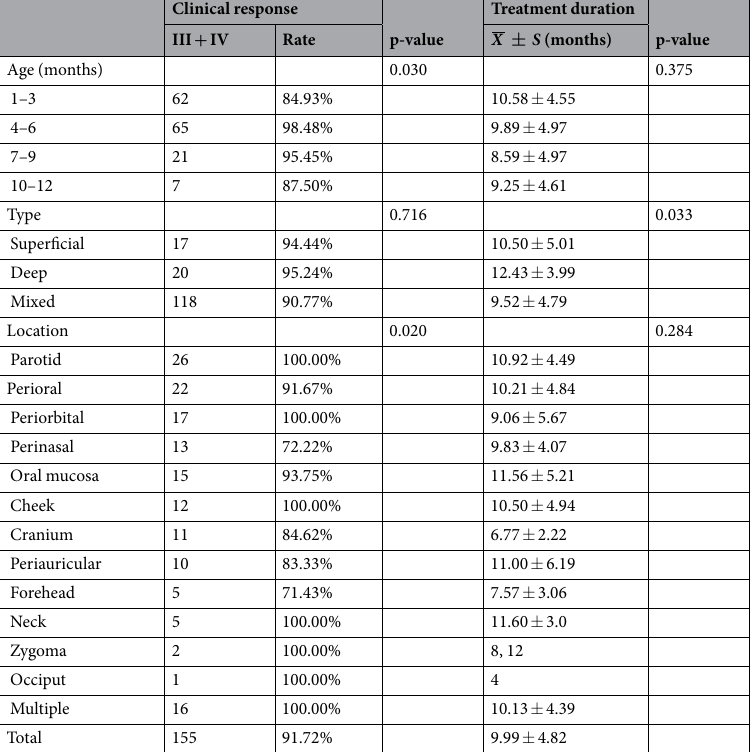
Table 2. The infantile haemangioma therapeutic response and treatment